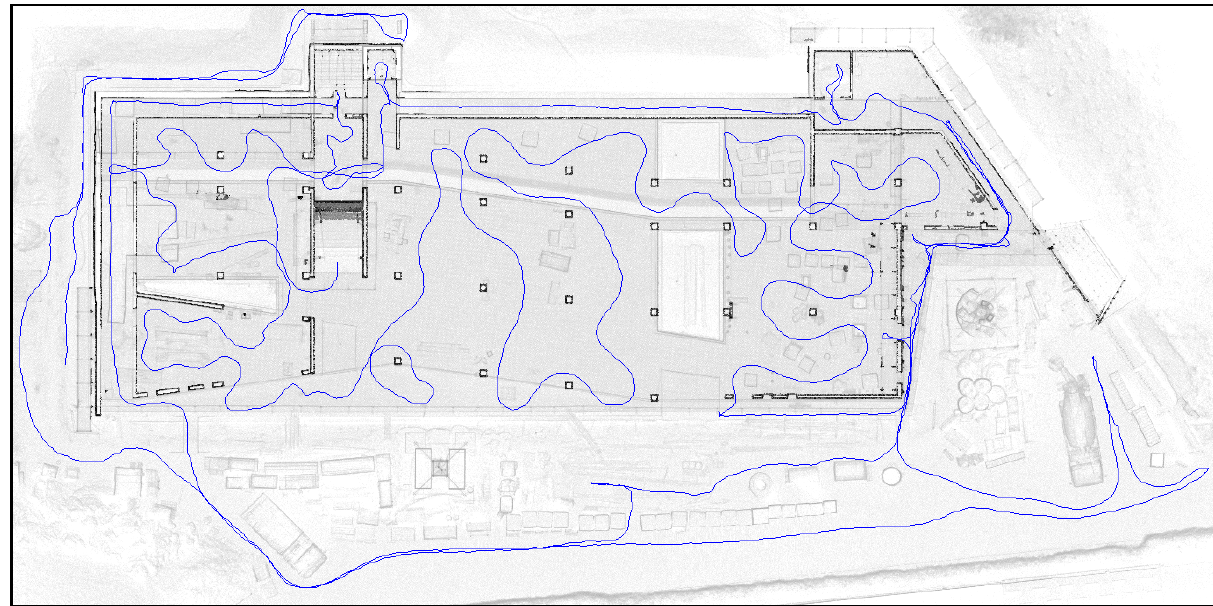
Figure 3. Plan view of the last acquisition showing the trajectory followed at the ground floor.